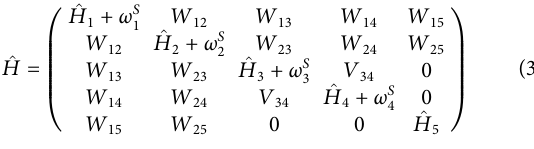
where ψ k ξ ( R, θ , t ) is the nuclear wavefunction of the | ξ 〉 state for a